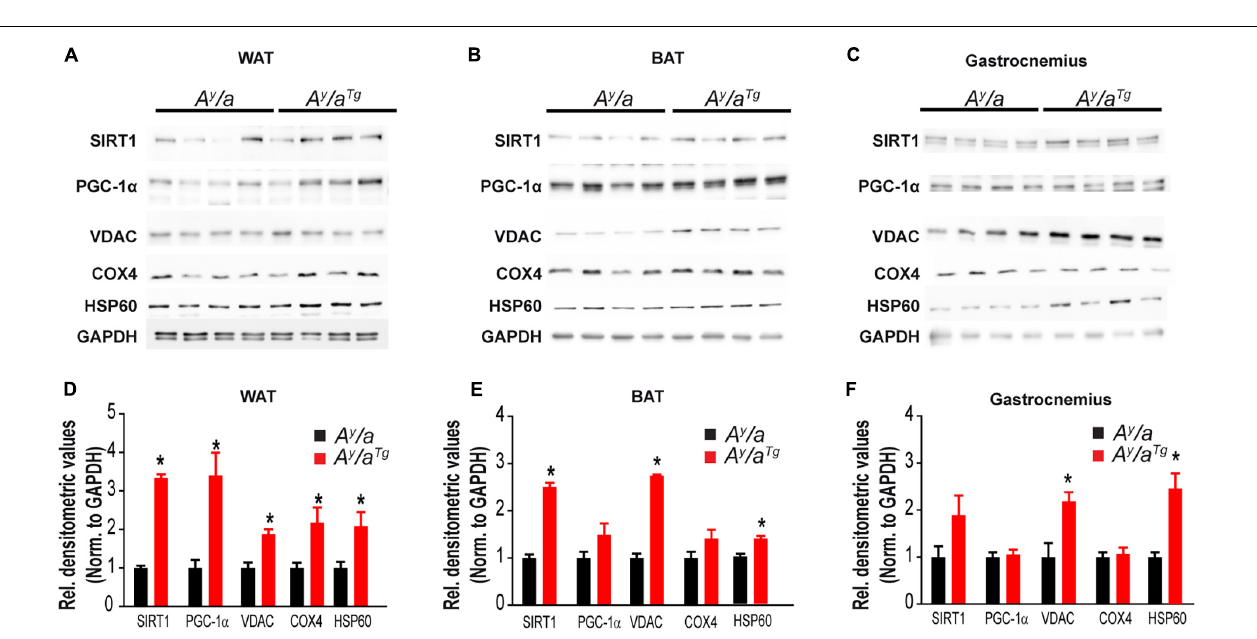
FIGURE 2 | Energy expenditure. (A) O 2 consumption and (B) CO 2 respiration were measured by indirect calorimetry in female mice. (C) Respiratory exchange ratios (RER) were calculated during indirect calorimetry measurements. (D) Voluntary physical activity was measured during indirect calorimetry. n = 6. Averages ± SEM.